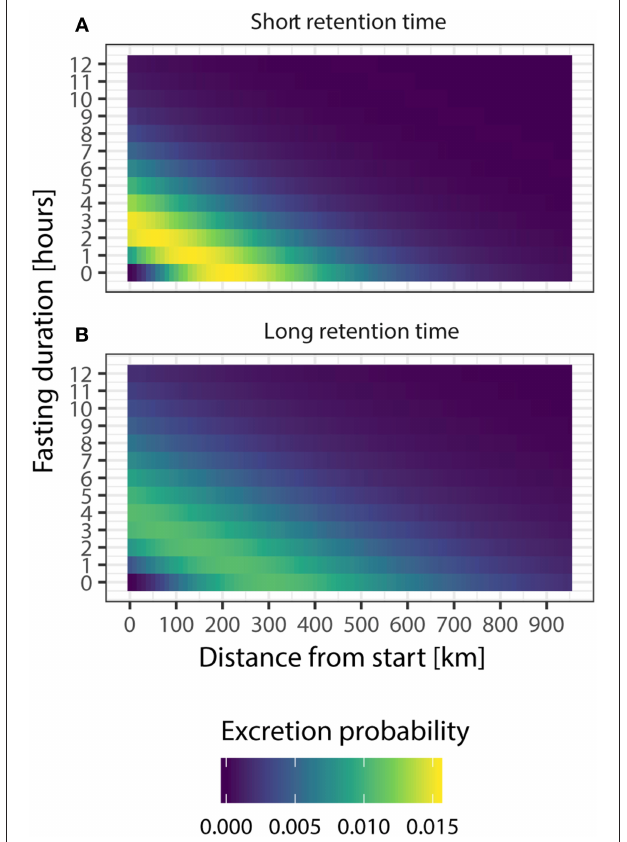
FIGURE 5 | The effect of the duration of pre-migratory fasting on seed dispersal kernels, expressed as the excretion probability over distance from the departure location, for the short (a) and long (b) retention time scenarios. Note that the probability of seeds to be dispersed away from the location where they are consumed drops to close to 0 if mallards would stop foraging 12h prior to departure. In this figure, mallards are assumed to fly to their destination without using stopovers.